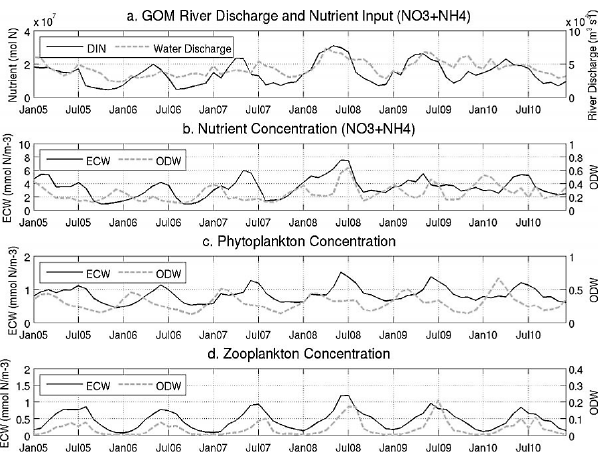
Fig. 10. Monthly mean time series of (a) river discharge and DIN loading, (b) surface DIN concentration, (c) surface phytoplankton concentration, and (d) surface zooplankton concentration on the shelf, and deep-sea areas over the entire gulf.